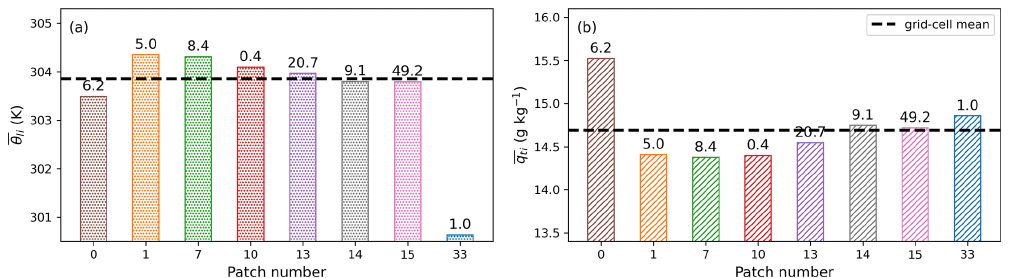
Figure 3. Diurnal cycle of the derived surface properties using HOM and HET approaches in local time (LT), including the variances of (a) liquid water potential temperature (cid:104) θ (cid:48) l2 (cid:105) , (b) total water specific humidity (cid:104) q (cid:48) t2 (cid:105) and (c) their covariance (cid:104) θ (cid:48) on the ELM output and then passed into CLUBB as the surface boundary conditions. The solid lines denote the seasonal mean quantities and correspondingly the filled areas indicate the 25% to 75% quartiles over the period from June to August 2015.